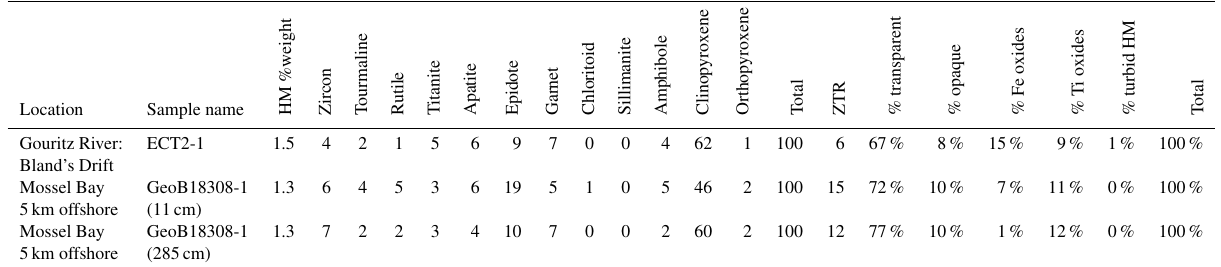
Table 4. Mineralogical composition of heavy minerals in silt and sand fraction (15–500m) of marine sediments from GeoB18308-1 and Gouritz River